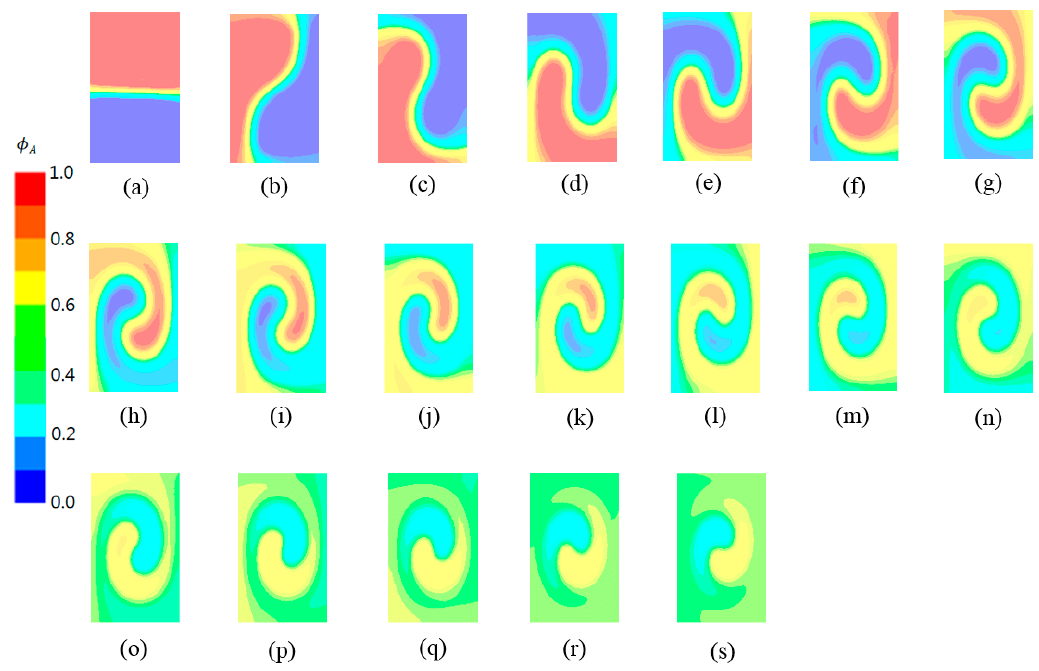
Figure 6. Mass fraction contours of the fluid A at several cross sections along the outlet branch: ( a ) θ = 0, ( b ) θ = π , ( c ) θ = 2 π , ( d ) θ = 3 π , ( e ) θ = 4 π , ( f ) θ = 5 π , ( g ) θ = 6 π , ( h ) θ = 7 π , ( i ) θ = 8 π , ( j ) θ = 9 π , ( k ) θ = 10 π , ( l) θ = 11 π , ( m ) θ = 12 π , ( n ) θ = 13 π , ( o ) θ = 14 π , ( p ) θ = 15 π , ( q ) θ = 16 π , ( r ) θ = 17 π , ( s ) θ = 18 π .